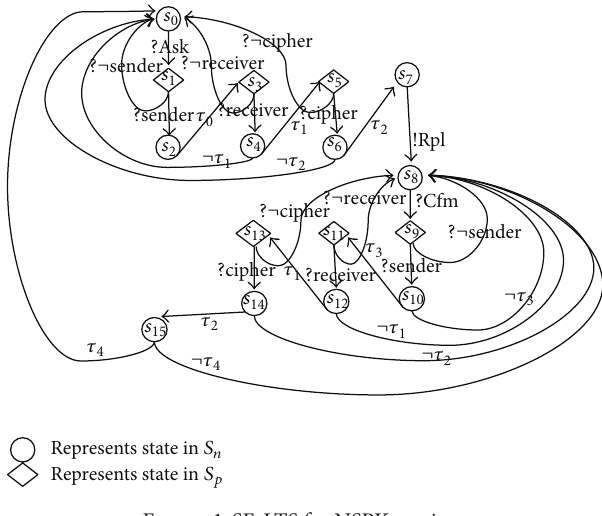
Figure 1: SE-LTS for NSPK